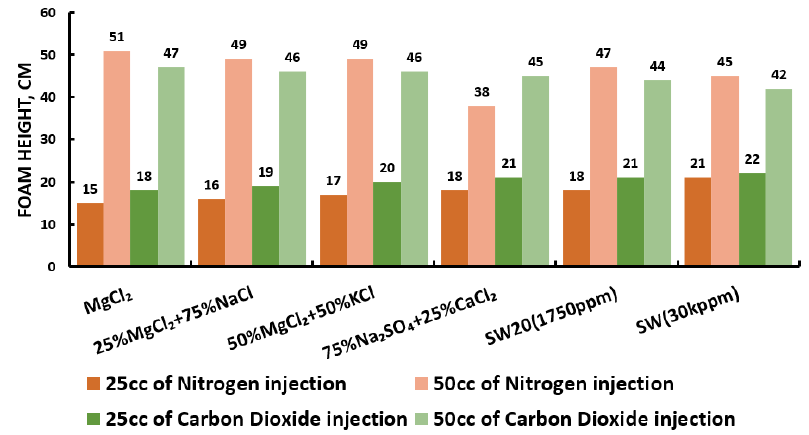
Figure 27. Surfactants screening: foamability test—CTAB at 25 ◦ C.